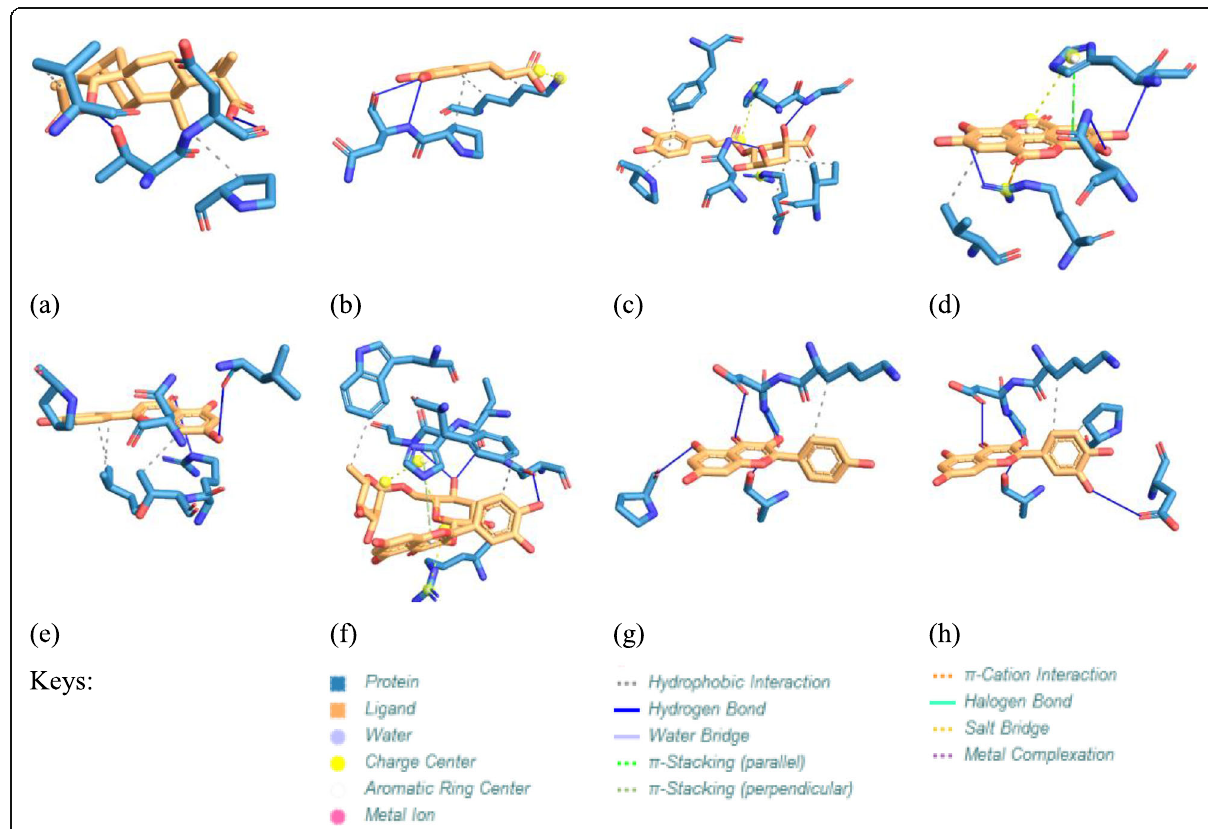
Fig. 10 The identification of non-covalent interactions between TNFL8 and the selected ligands a xylopic acid, b caffeic acid, c chlorogenic acid,